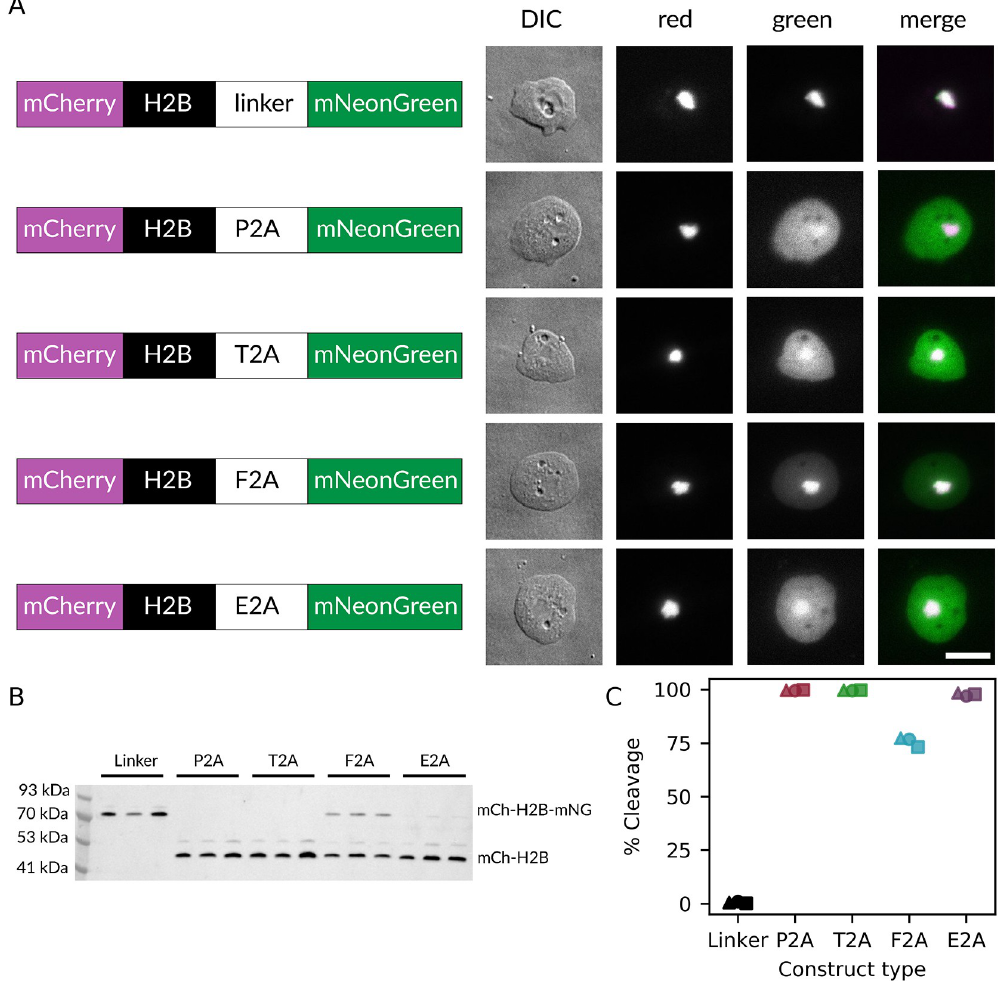
Fig 1. 2A viral peptides allow for expression of multiple genes in D. discoideum . A: Microscopy images of AX4 D. discoideum cells expressing either a directly linked mCherry-H2B-linker-mNeonGreen construct or one of the different mCherry-H2B-2A-mNeonGreen constructs. Representative differential interference contract (DIC), green fluorescence, red fluorescence, and a merged fluorescent image are shown for each construct. Each construct was assembled with an actin15 promoter and an actin8 terminator. Scale bar = 10 μ m. B: mCherry western blot of AX4 cells expressing each construct displayed in (A). Blot shows data for three independent transfections. C: Quantification of mCherry western blot. Percent cleavage was calculated as the intensity of the ‘cleaved’ mCherry-H2B band over the total intensity of the uncleaved and the cleaved bands. Each marker shape indicates an independent experiment ( 4 : replicate 1, ◯ : replicate 2, □ : replicate 3). expression differences due to variable promoter strength. The green and red fluorescence lev- els measured by flow cytometry serve as proxies for the expression levels of mNeonGreen and mScarlet-I, and their values relative to each other reveal the relative expression levels of the two fluorescent proteins (Fig 2B). Full details of flow cytometry gating and results are shown in S2–S10 Figs. Both P2A and T2A polycistronic constructs show a clear bias toward the first protein being more highly expressed (Fig 2C). Specifically, the green-to-red fluorescence ratios for both the P2A and the T2A constructs were higher than those of the flexible linker con- structs when mNeonGreen was upstream, and lower when mNeonGreen was downstream, consistent with the idea that the upstream protein is expressed in higher quantities than the downstream one. This effect translates into higher bias scores and was more pronounced for